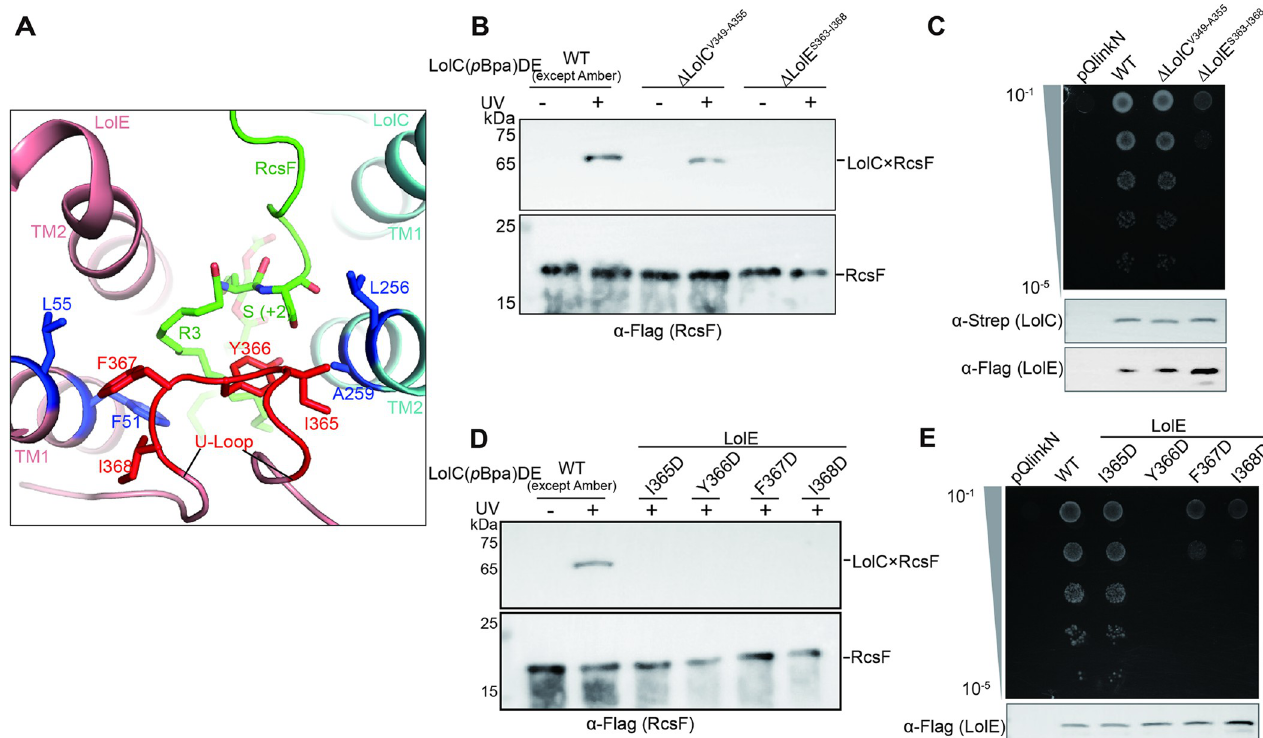
Fig 5. The U-loop maintains the configuration of the substrate-binding cavity. ( A ) Top view of the V-shaped cavity showing that the U-Loop (red) interacts with TMs. Residues from both TM1 LolE and TM2 LolC (in blue) make hydrophobic contacts with the U-Loop (red). ( B and C ) The 6 residues (S363-I368 of LolE) that consist of the U-Loop and the 7 residues (V349-A355 in Loop LolC ) were deleted, respectively. Photo-crosslinking (B) and complementation assays (C) showing that the U-Loop is crucial for LolCDE function. ( D and E ) Residues (in red stick model) in (A) were substituted with Asp for photo-crosslinking (D) and complementation assays (E) respectively. Data shown in (B to E) are representatives of 3